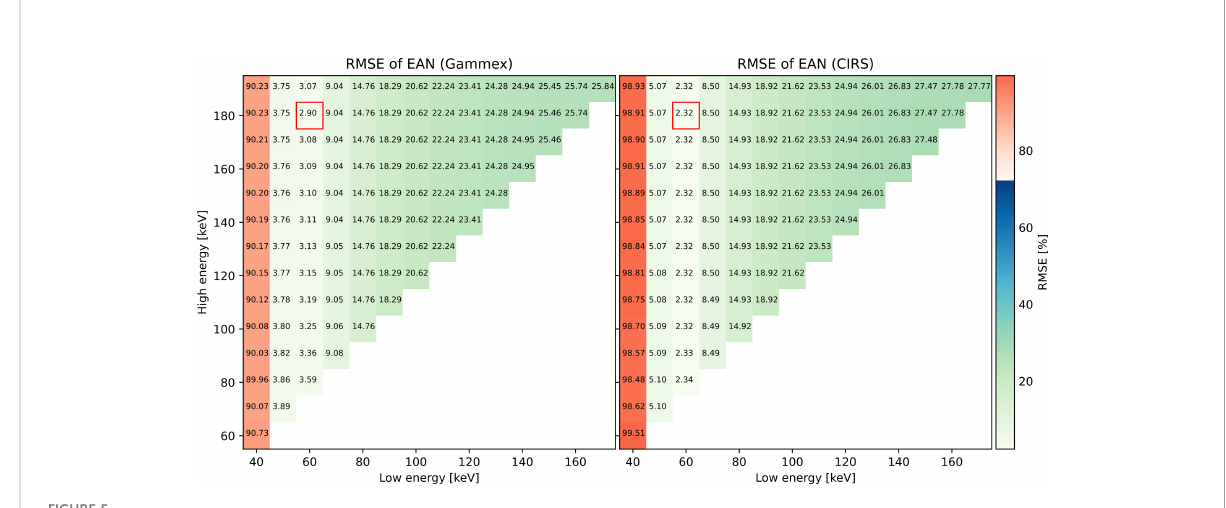
FIGURE 5 RMSEs of EAN for all the monoenergy